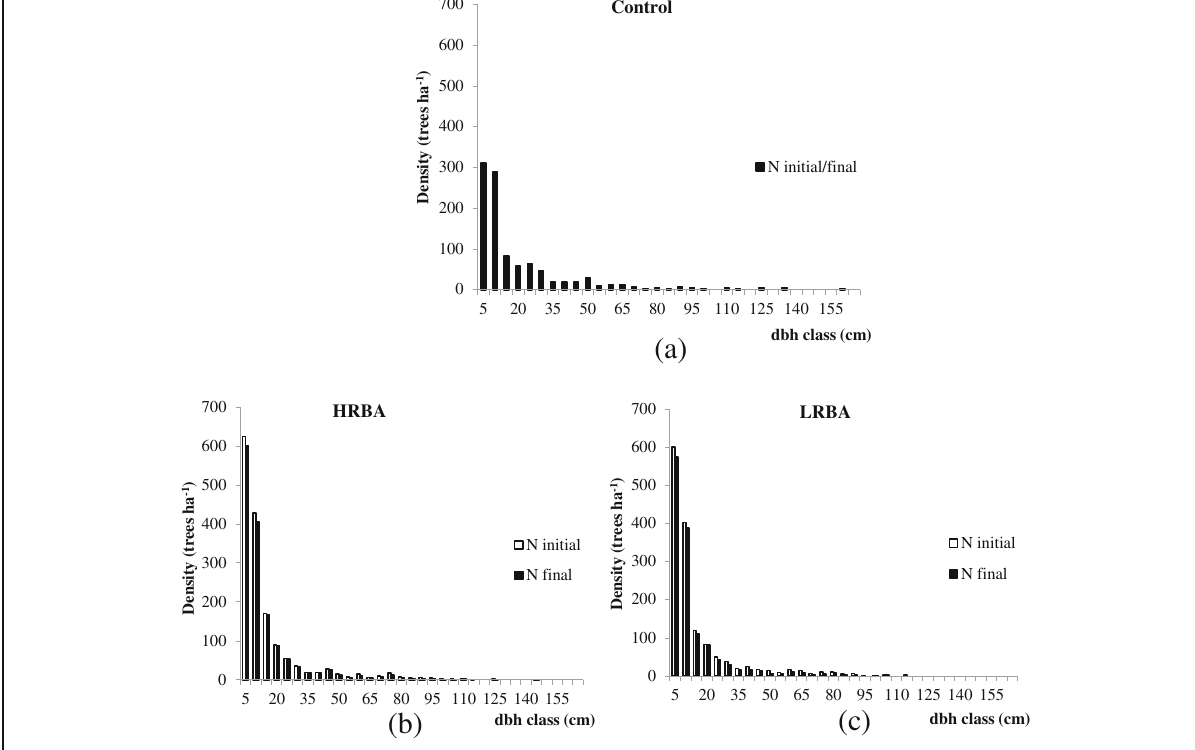
Fig. 2 Observed diameter distributions of a the old-growth control, b high residual basal area (HRBA) and c low residual basal area (LRBA). The histograms represent the average number of trees per hectare per treatment (four plots each) before and after